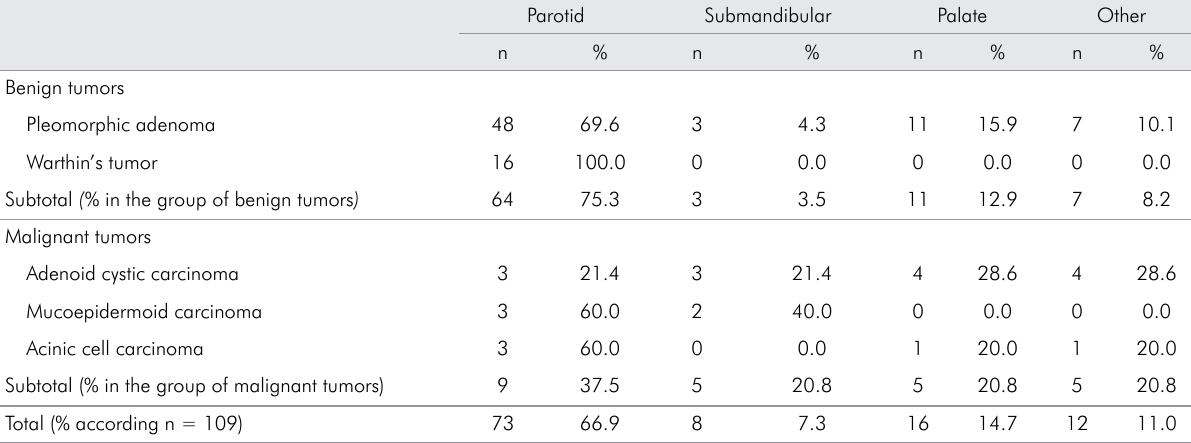
Table 1. Distribution of 109 salivary gland tumors according to anatomic location.